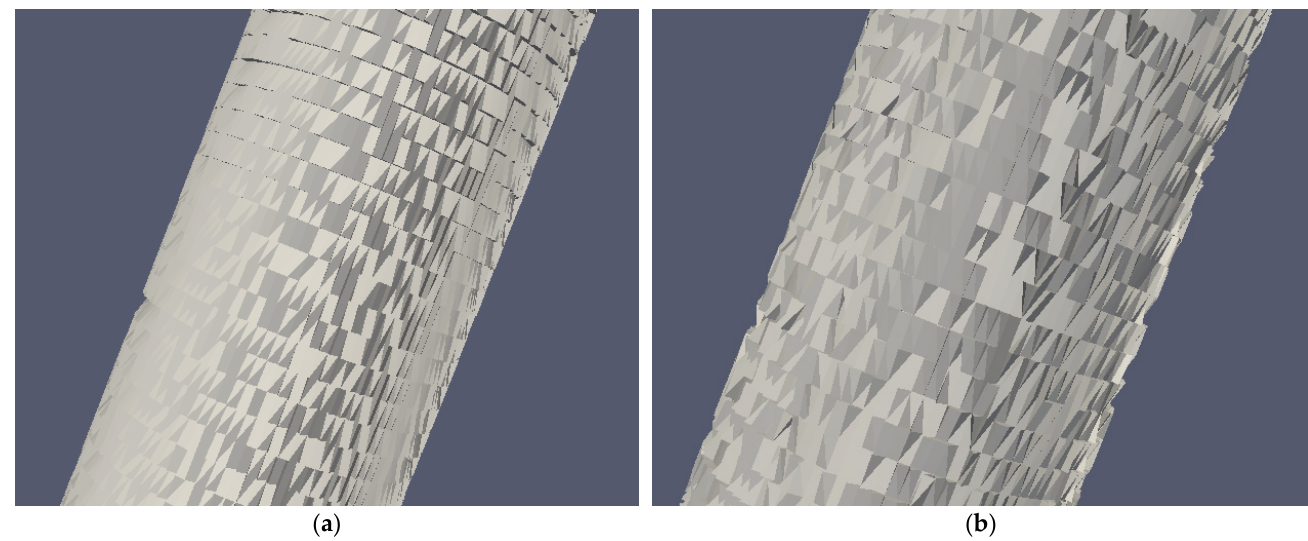
Figure 5. Detail of the degraded geometries: ( a ) PCL filament at 24 h; ( b ) PCL:MCC 98:2 filament at 48 h.